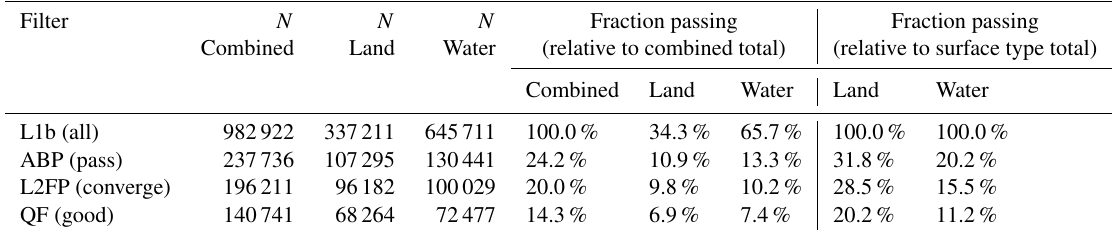
Table 1. Summary statistics of the filtering for each stage of the analysis. Results are shown for the nadir–land, glint–water, and combined soundings